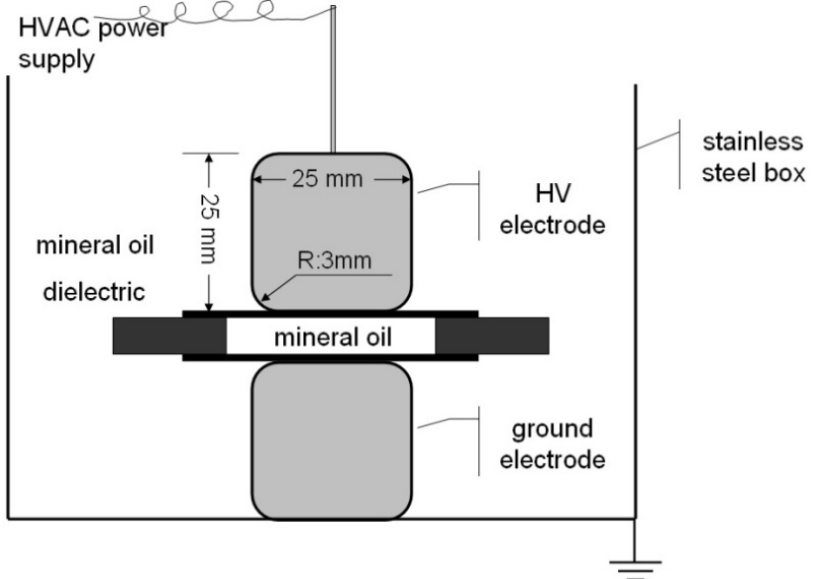
Figure 7. Diagram of